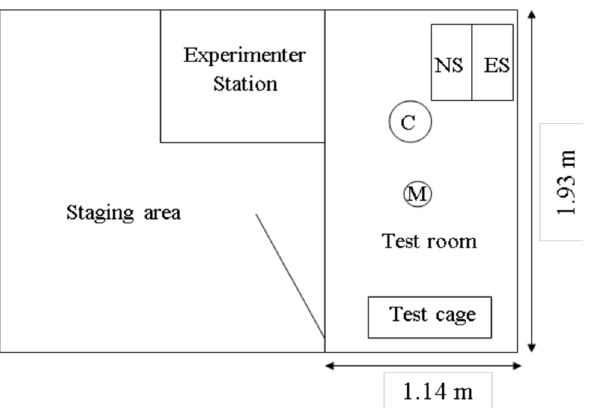
Fig 1. Diagram of experimental setup. Letters indicate equipment placement; M = microphone; C = video camera; NS = speaker presenting noise stimulus; ES = speaker presenting elicitation stimulus.